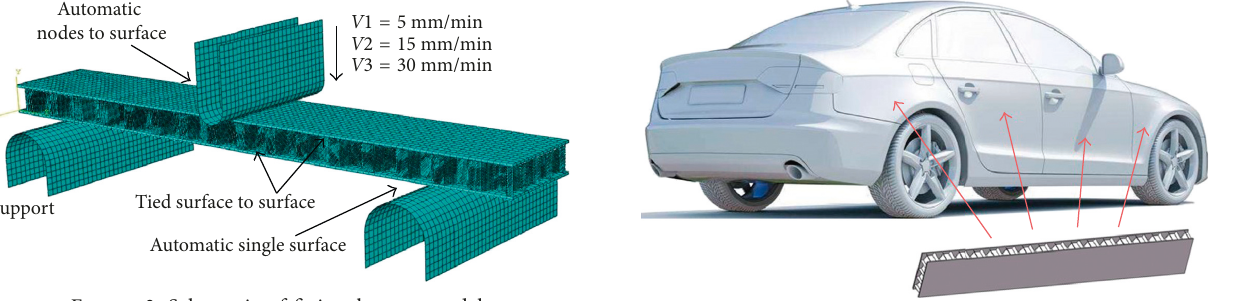
Figure 4: Schematic of sandwich structures with aluminium honeycomb core and CFRP skins in vehicle body.